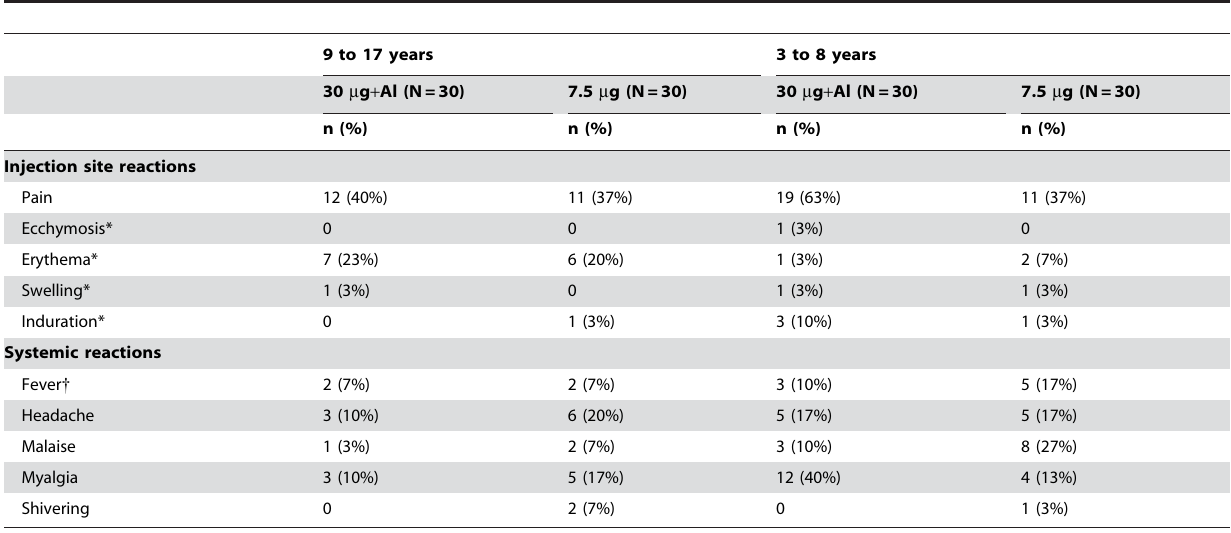
* any measurable reaction . 0 cm. { oral temperature $ 37.4 u